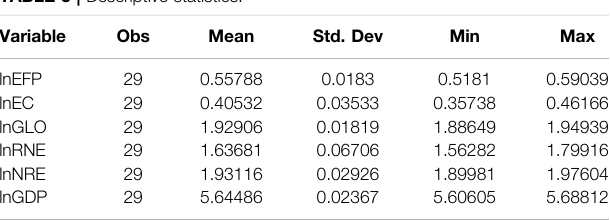
TABLE 3 | Descriptive